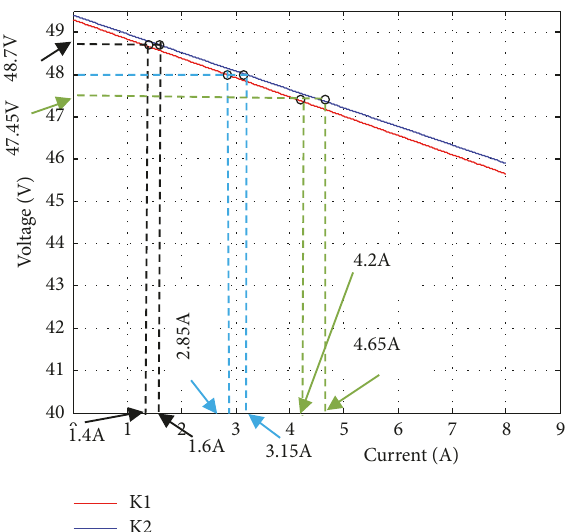
Figure 15: 10% mismatch in load regulation characteristic of the droop method for the two converters.